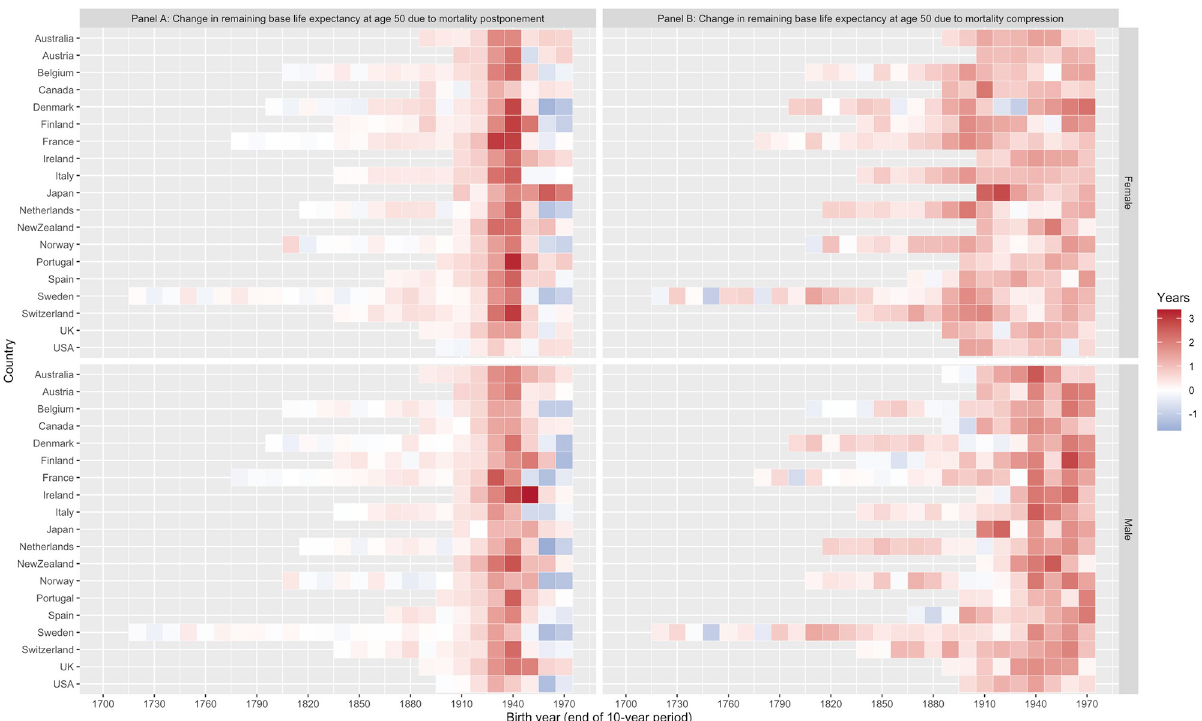
Fig 7. Changes in remaining base life expectancy at age 50 across 10-year birth cohorts separated into the portion due to postponement and the portion due to compression for males and females. N OTE : These show the median changes in remaining cohort life expectancy at age 50 due to ; ~ d g for each country. Confidence bands for earlier cohorts are small, but compression and postponement estimated from our posterior sample f ~ l 50 widen for the most recent two decades shown. Detailed results for each country, along with confidence intervals, are available in the supplementary